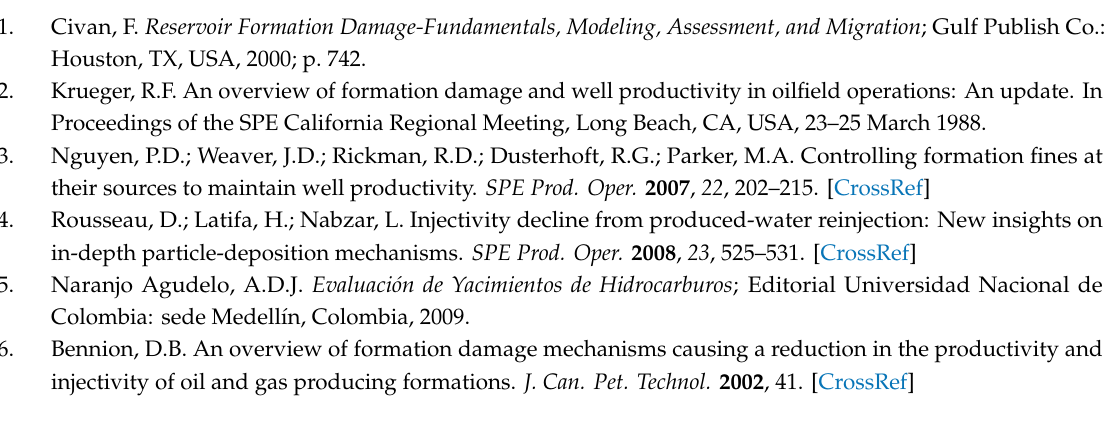
Figure S1. TEM analysis for the MgO nanoparticles samples (a) M11, (b) M42, and (c) M86, where the number of the nomenclature refers to the hydrodynamic diameter (nm) found for each particle by DLS technique at 25 ◦ C. Figure S2. Zeta Potential of the three synthesized MgO nanoparticles at 25 ◦ C. Table S1. Properties of porous media employed for the oil recovery